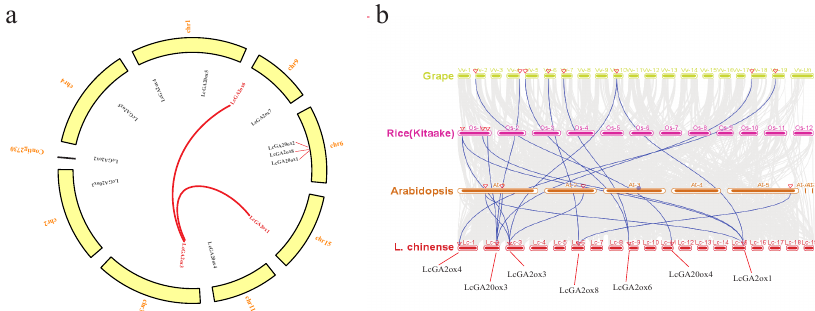
Figure 4. Genome-wide synteny analysis of GA2ox and GA2ox gene family among L. chinense and other three species. ( a ): Distribution and segmental duplication of GAox genes in L. chinense . The yellow panel shows the 8 chromosomes using a circle, and the contig are display through the black line. Red lines connecting homologous genes; chromosome numbers are marked outside of the circle. ( b ): Synteny analysis of GAox genes between L. chinense , Arabidopsis , grape, and rice (Kitaake). Gray lines in the background indicate the collinear blocks within L. chinense , Arabidopsis , grape, and rice (Kitaake) genomes, while the blue lines highlight the syntenic GAox gene pairs. Different gene pairs were highlighted by red